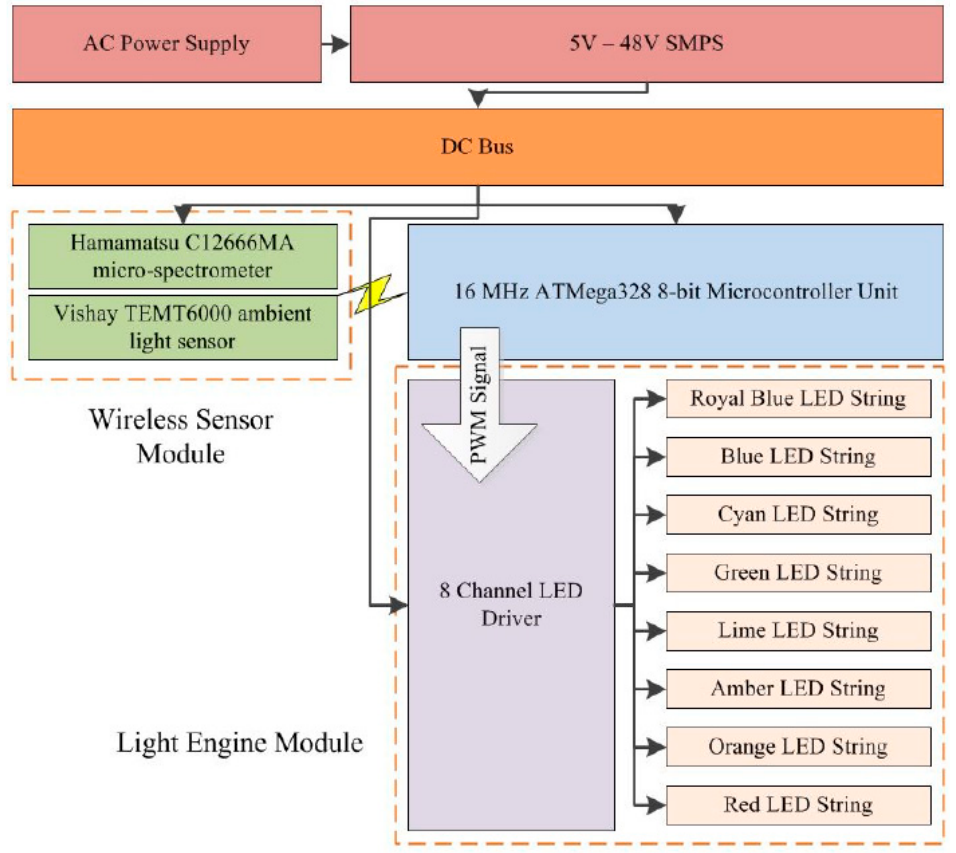
Figure 8. The block diagram of the lighting system [29].